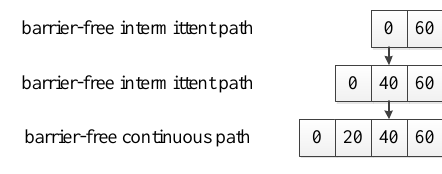
Figure 4. The connection operator.